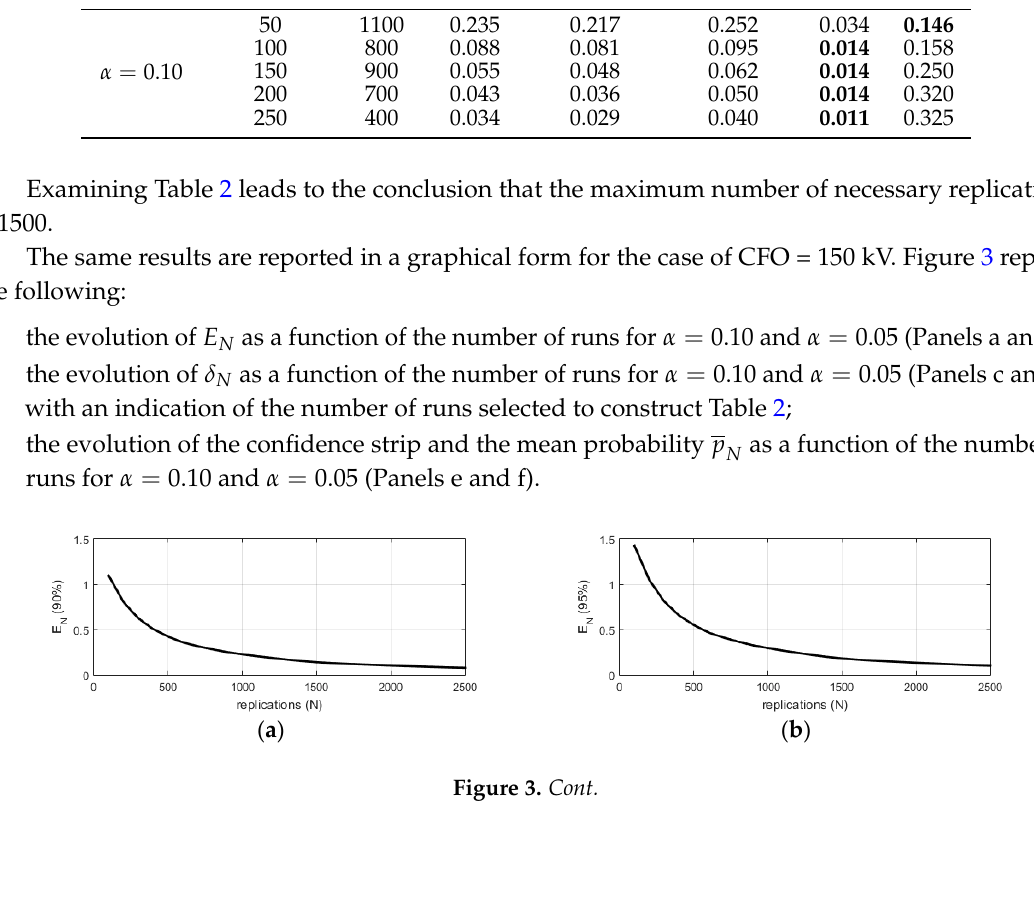
Table 2. Stopping criterion results for Test1.